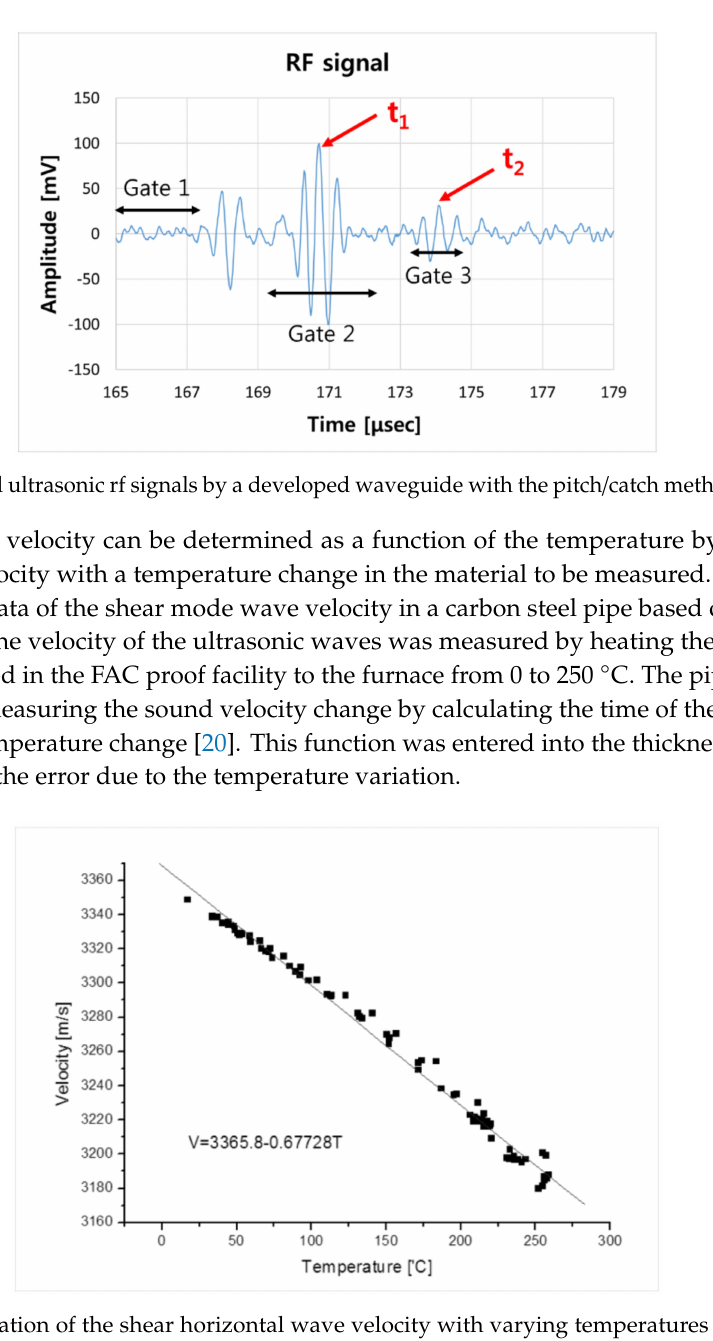
Figure 4. Calibration of the shear horizontal wave velocity with varying temperatures for a carbon steel pipe SA